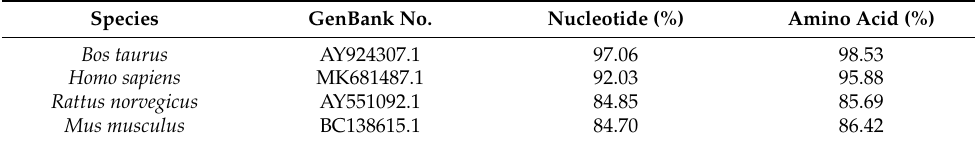
Table 3. Similarity analysis of nucleotide and amino acid of EGR1.